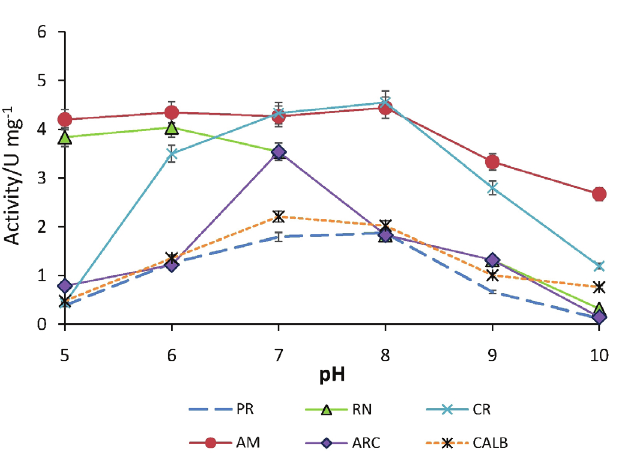
Fig. 3a – Activity of lipases at different pH values (incuba- tion in buffer solution)